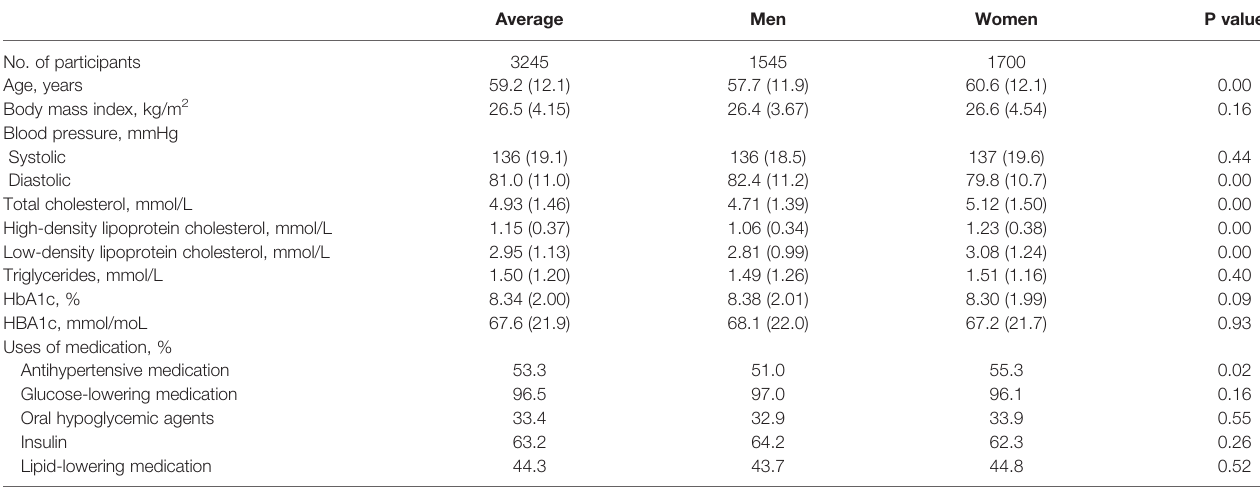
TABLE 1 | Baseline characteristics of inpatients with type 2